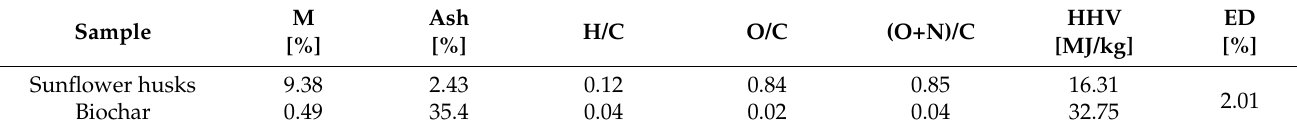
Table 2. Properties of sunflower husks and biochar (M—the moisture content; HHV—the higher heating value; ED—the energy